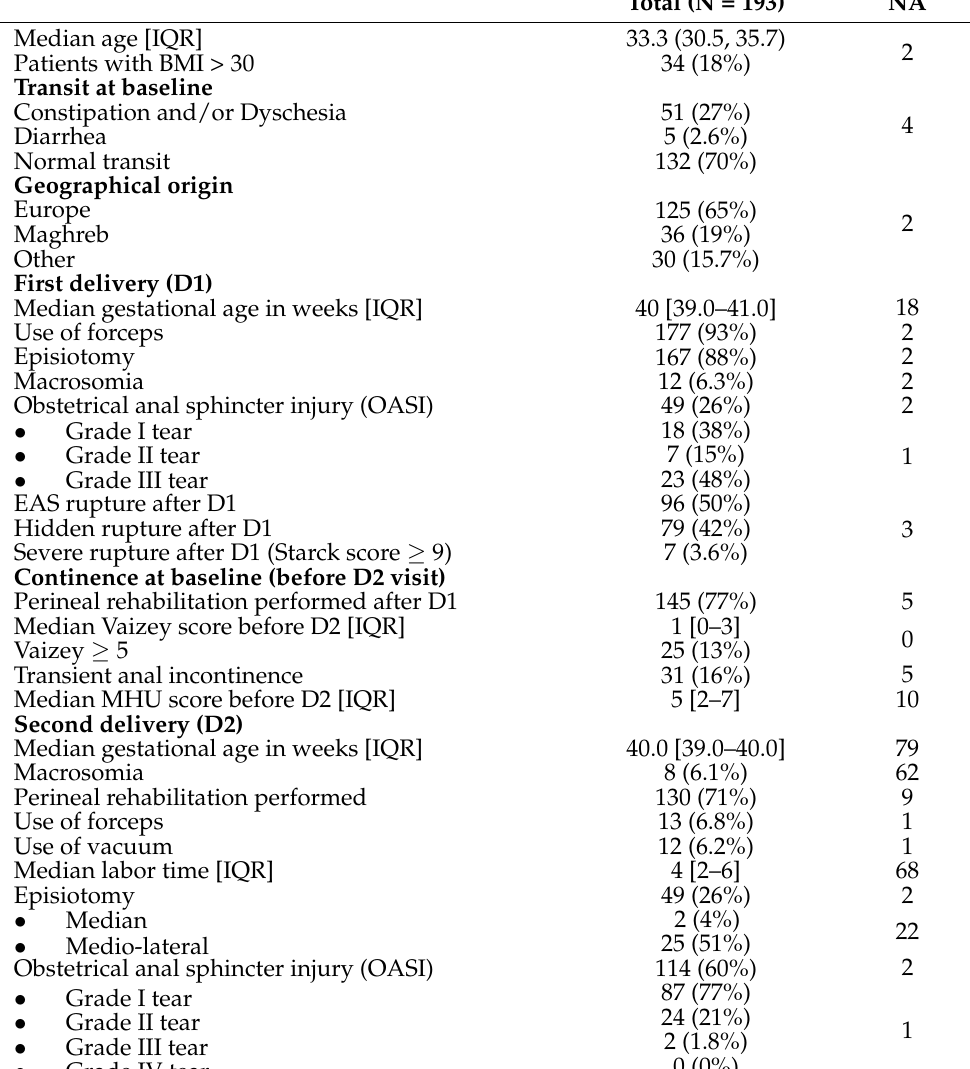
Table 2. Characteristics of the subgroup of women delivering vaginally during